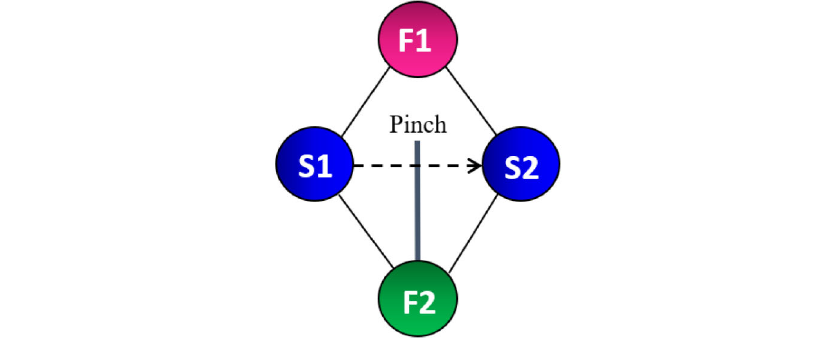
Figure 6. Adding another field for better control of the